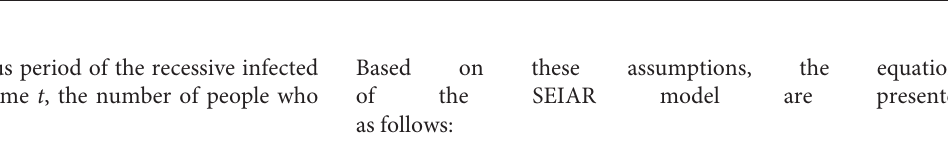
FIGURE 2 | Flowchart of the SEIAR model.